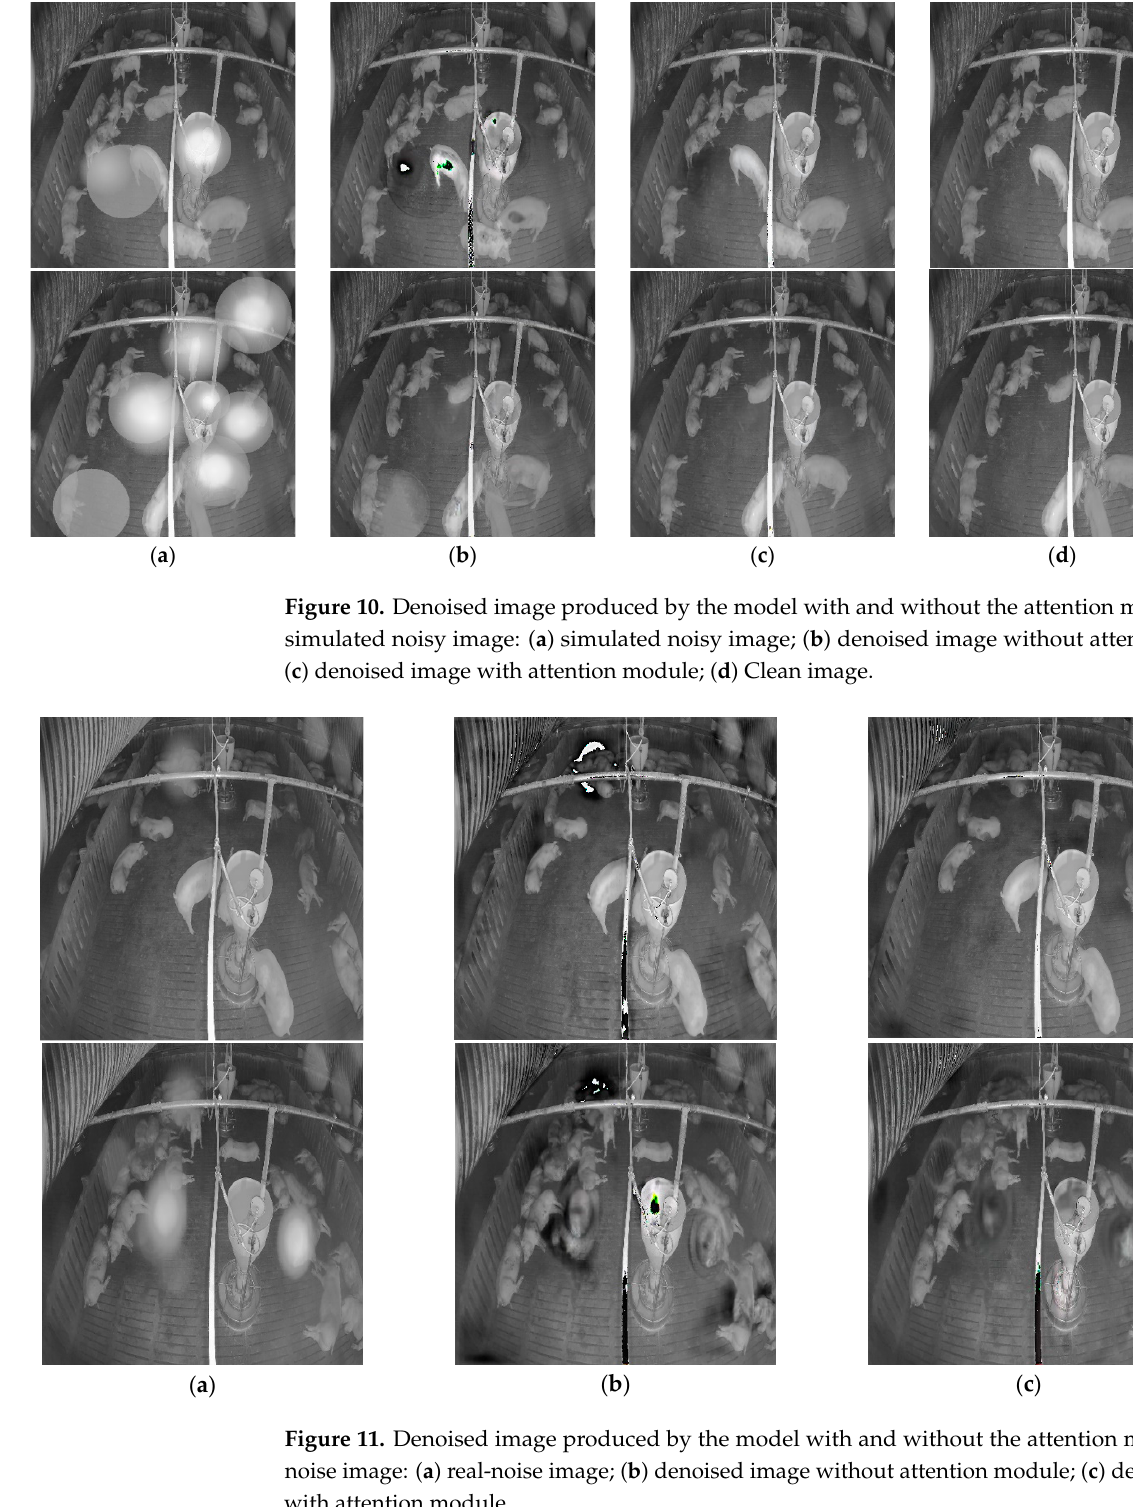
( b ) Figure 12. Attention map calculated by the attention module on simulated noisy images: ( a ) simu ‐ lated noisy image; ( b ) heatmap of the corresponding attention map of each layer in the model. ( a )